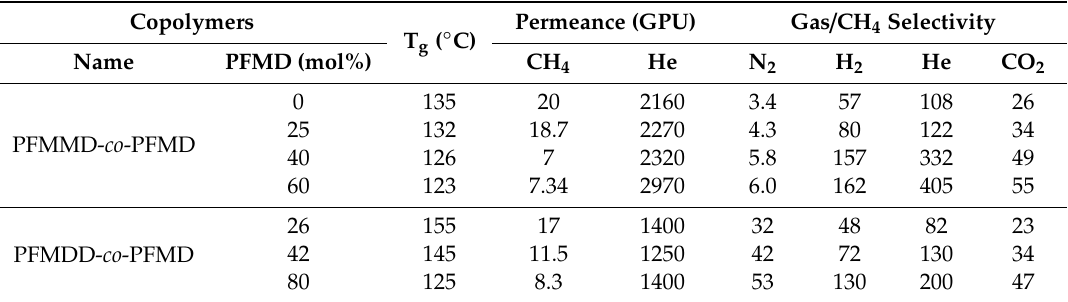
Table 5. Gas Separation Properties of Thin-Film Composite Membranes Based on PFMMD- co -PFMD and PFMDD- co -PFMD at 22 ◦ C [24,27].